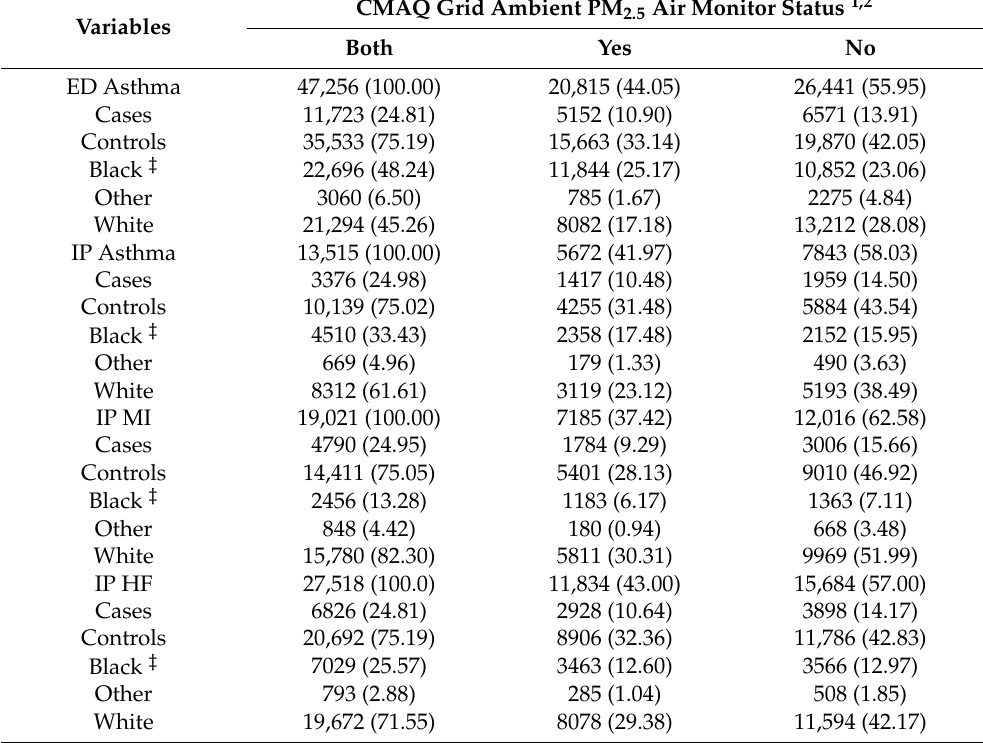
Table 7. Demographic attributes for respiratory–cardiovascular chronic disease cases and controls and patients’ race by monitor status in the Baltimore study